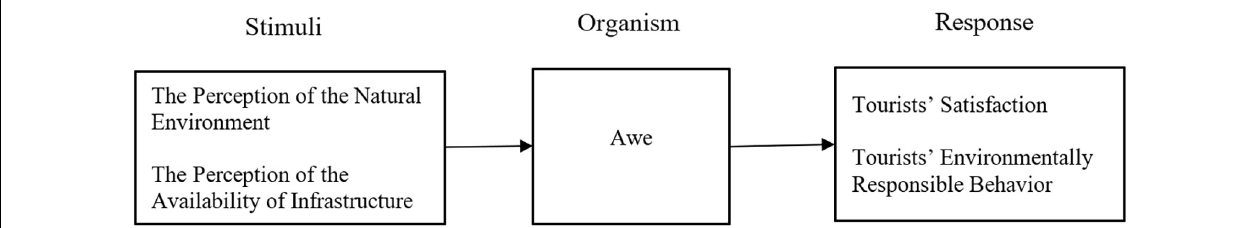
FIGURE 1 | The SOR model proposed in this